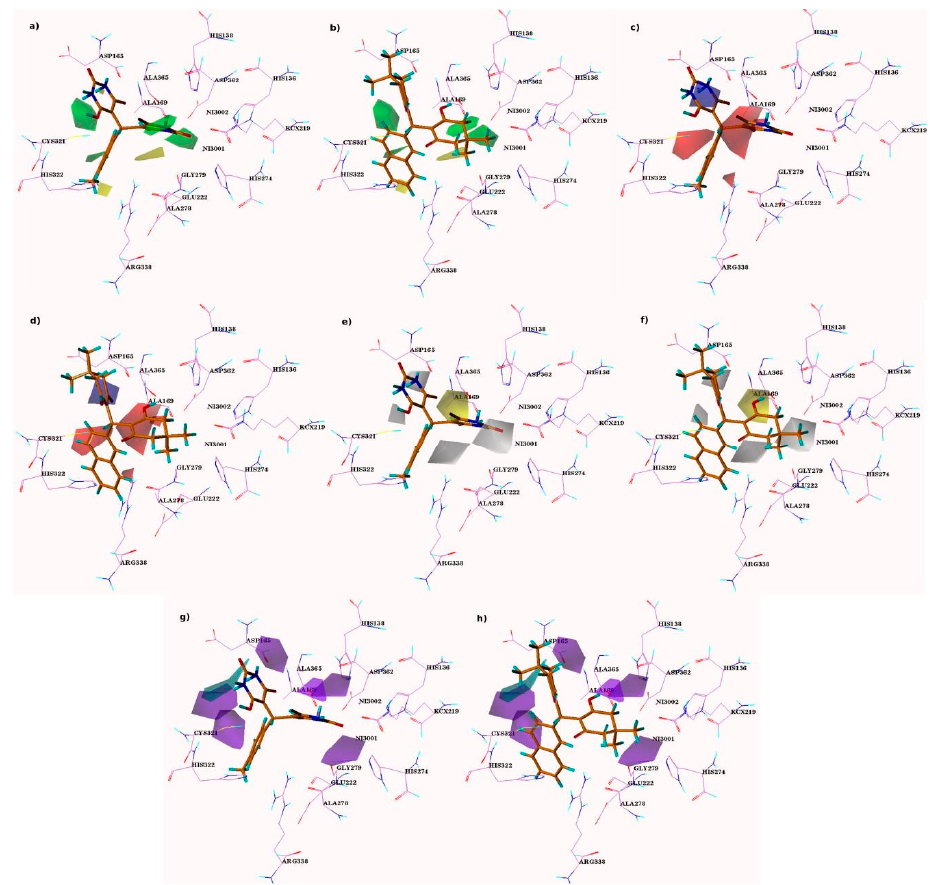
Figure 4. CoMSIA contour maps. Figure ( a , c , e , g ) displayed steric, electrostatic, hydrophobic, as well as donor contour maps of compound 4i claimed as the most active; While, ( b , d , f , h ) are representative of compounds, 5s claimed as one of the least active compounds within the series.